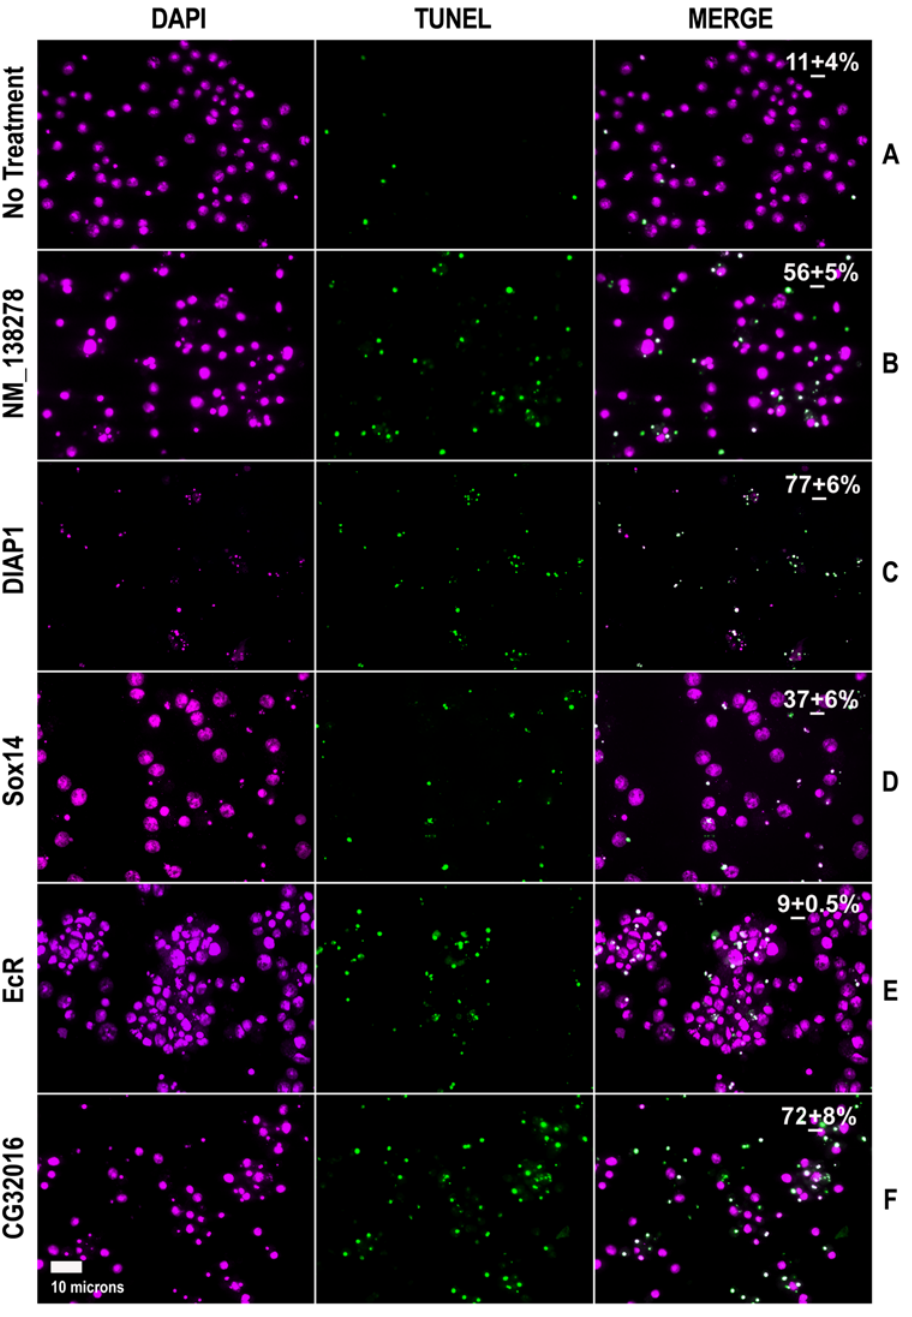
Figure 4. TUNEL assay identifies genes with cell death-related effects. DAPI staining (magenta) and TUNEL assays (green) were performed 3 days following addition of dsRNA and ecdysone to l(2)mbn cells. The cells with no ecdysone and no dsRNA (No treatment) showed a background level of 11 + / 2 4% TUNEL positivity (Panel A). Ecdysone (not shown) and ecdysone plus the human dsRNA NM_138278-negative control resulted in an increase in TUNEL positive cells (56 + / 2 5%; Panel B). dsRNA corresponding to diap1 (control gene) increased TUNEL positive cells without (not shown) or with ecdysone treatment (77 + / 2 6%; Panel C). Ecdysone plus RNAi of Sox14 (Panel D) or EcR (Panel E) resulted in decreased TUNEL positive cells (37 + / 2 6% and 9 + / 2 0.5%, respectively), whereas ecdysone plus RNAi of a novel gene CG32016 (Panel F) increased TUNEL positive cells (72 + / 2 8%) compared to the negative control.